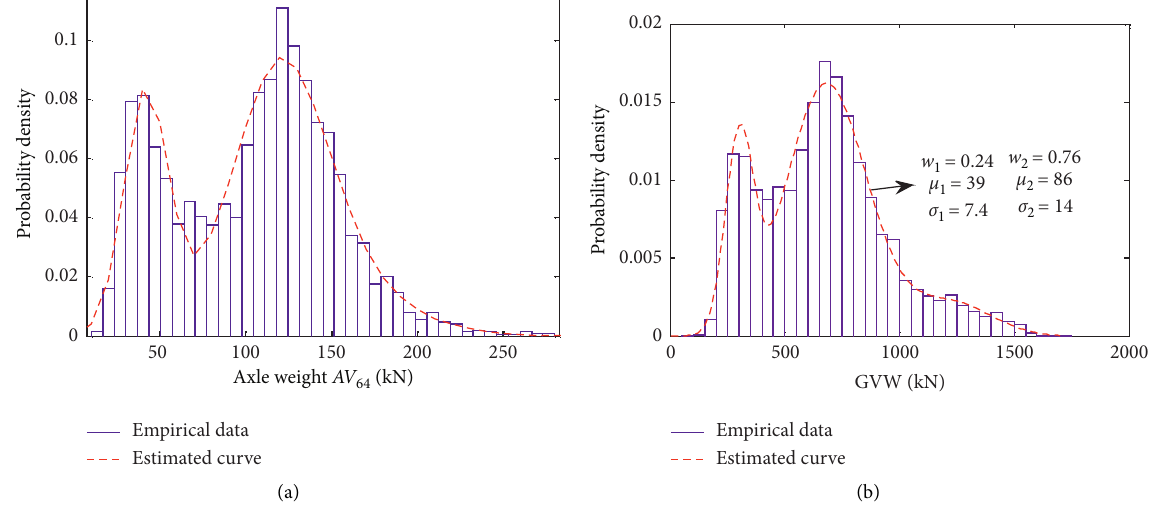
Figure 4: Probabilistic distribution of axle load of 6-axle trucks: (a) axle weight; (b) gross weight.